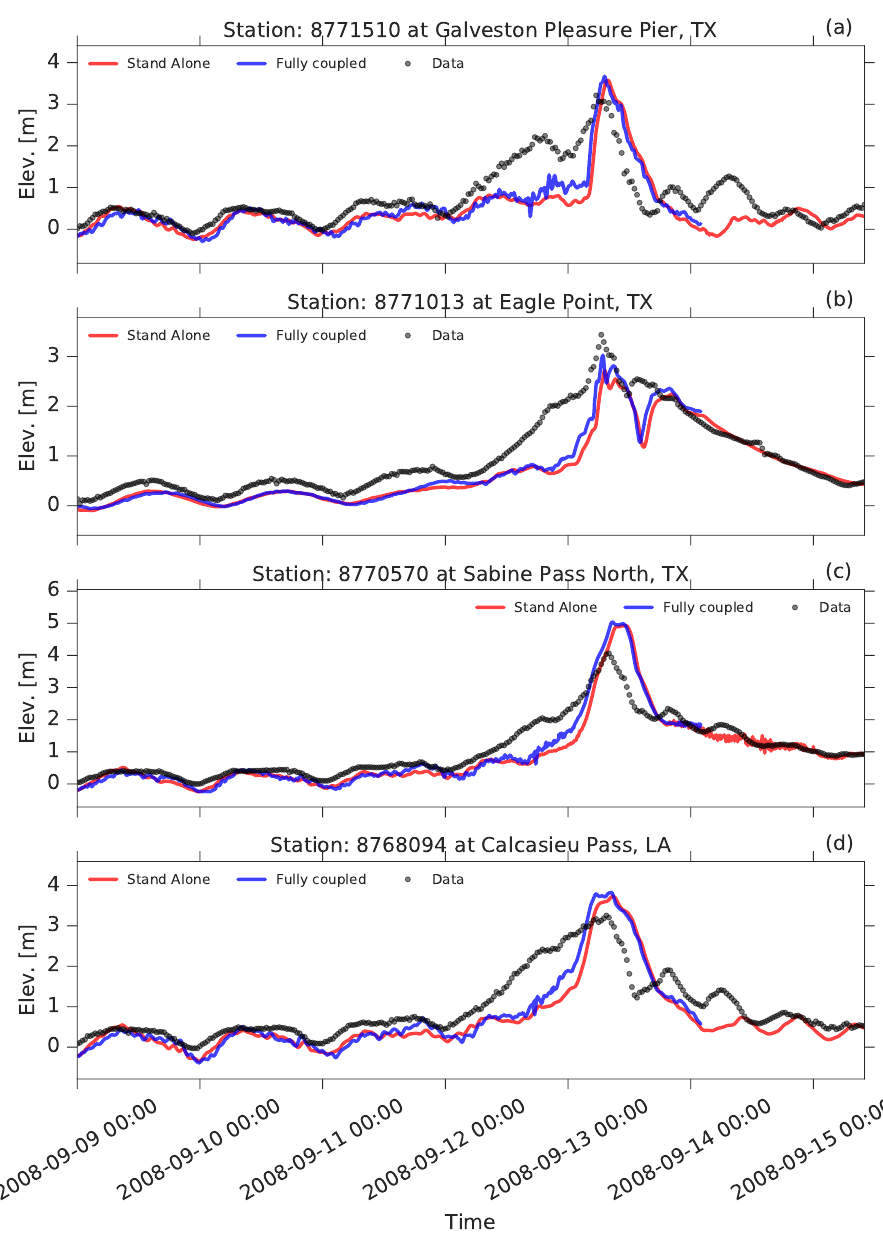
Figure 14. Time series of the total water level observations at the tidal gauges (locations shown in Figure 6). Black dots are the observations. Red and blue lines represent the Stand alone and the Fully coupled total water levels. a, b, c and d are models and observations of total water level provided by the NOAA’s Center for Operational Oceanographic Products and Services (CO-OPS). The ID numbers of the observation stations are shown in each panel title. All model configurations and results are pre-decisional and for official use